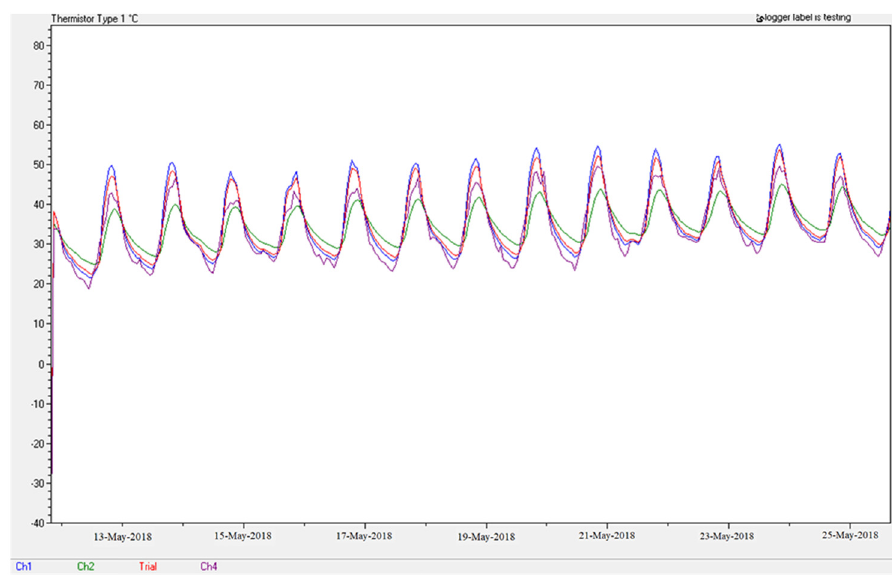
Figure 2: Relationship of temperature values with time from data logger